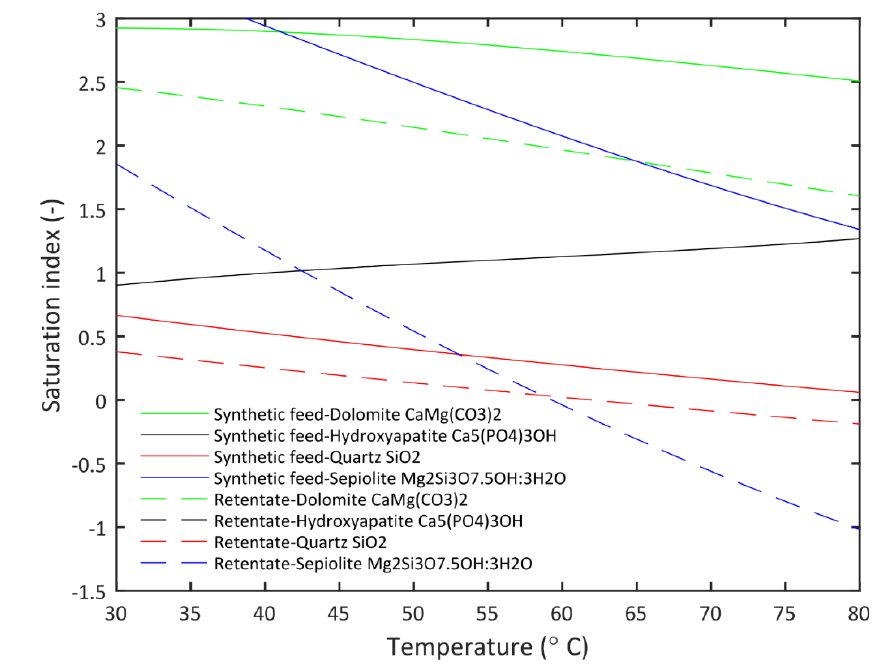
Figure A9. Aqueous speciation equilibrium of synthetic RO feed and retentate. Solid lines indicate the saturation indices of secondary precipitated minerals in the synthetic RO feed, while dashed lines indicate the corresponding saturation indices for the retentate. Modeled using PHREEQC software. At low temperatures, silica minerals typically form colloids rather than precipitates. Dolomite requires temperatures above 100 °C for precipitation activation.